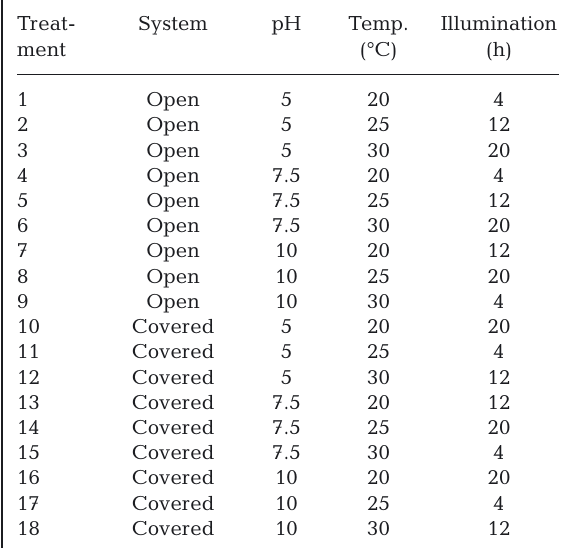
Table 1. L18 (2×3 3 ) Orthogonal experimental design scheme and the experimental conditions of 18 groups. Each group had 3 replicates